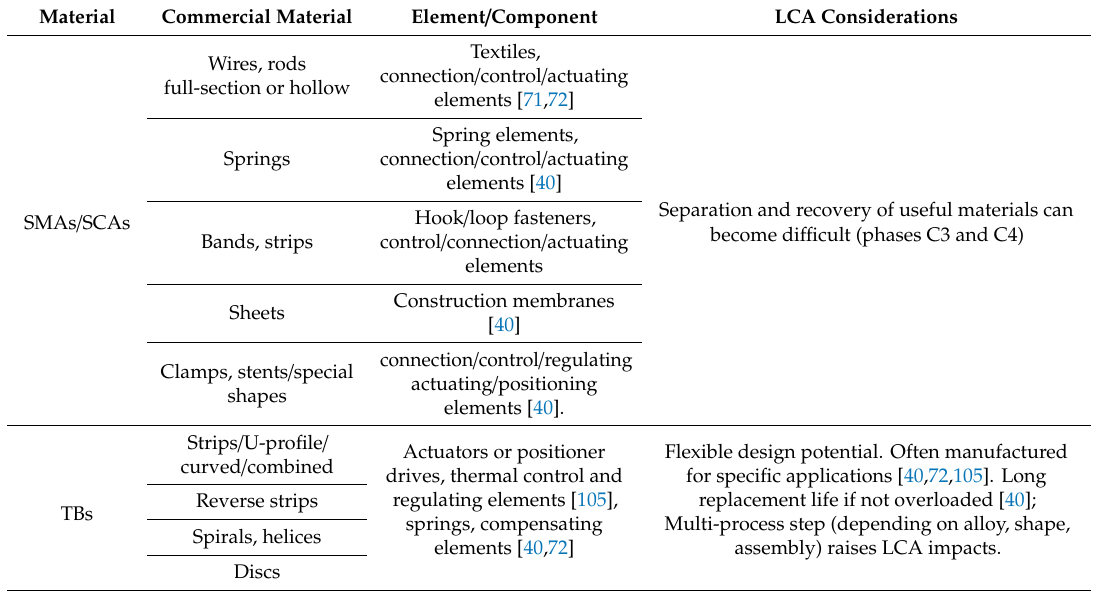
Table 9. Qualitative LCA considerations on adaptive metal / alloy integrating components.